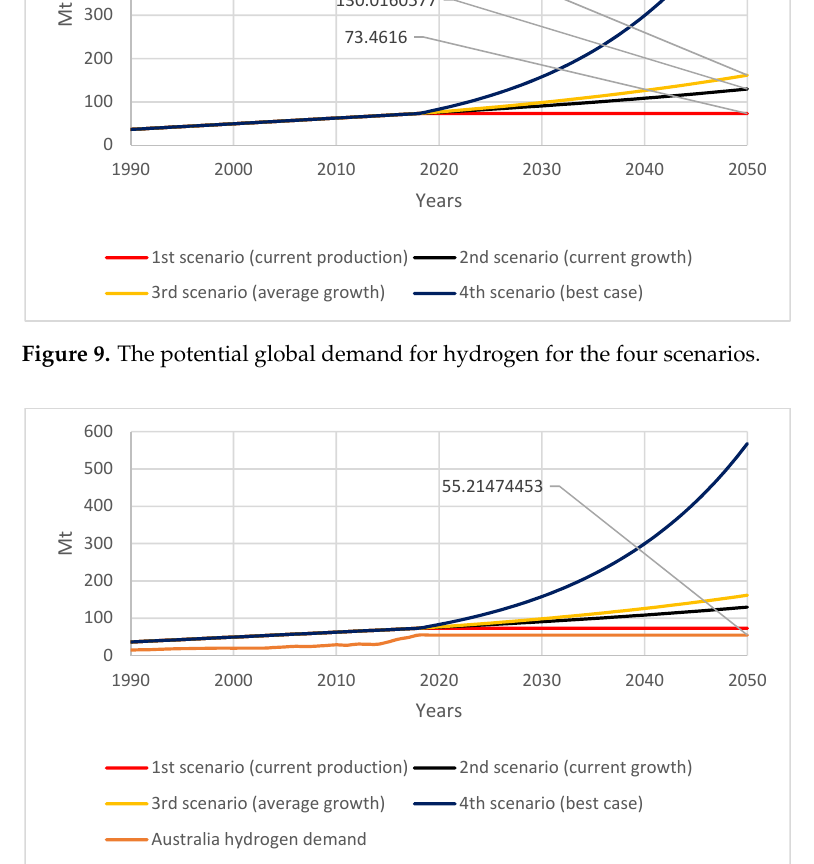
Figure 10. The potential hydrogen demand in the Australian context compared to the global demand for the four scenarios. Model Validating/Testing